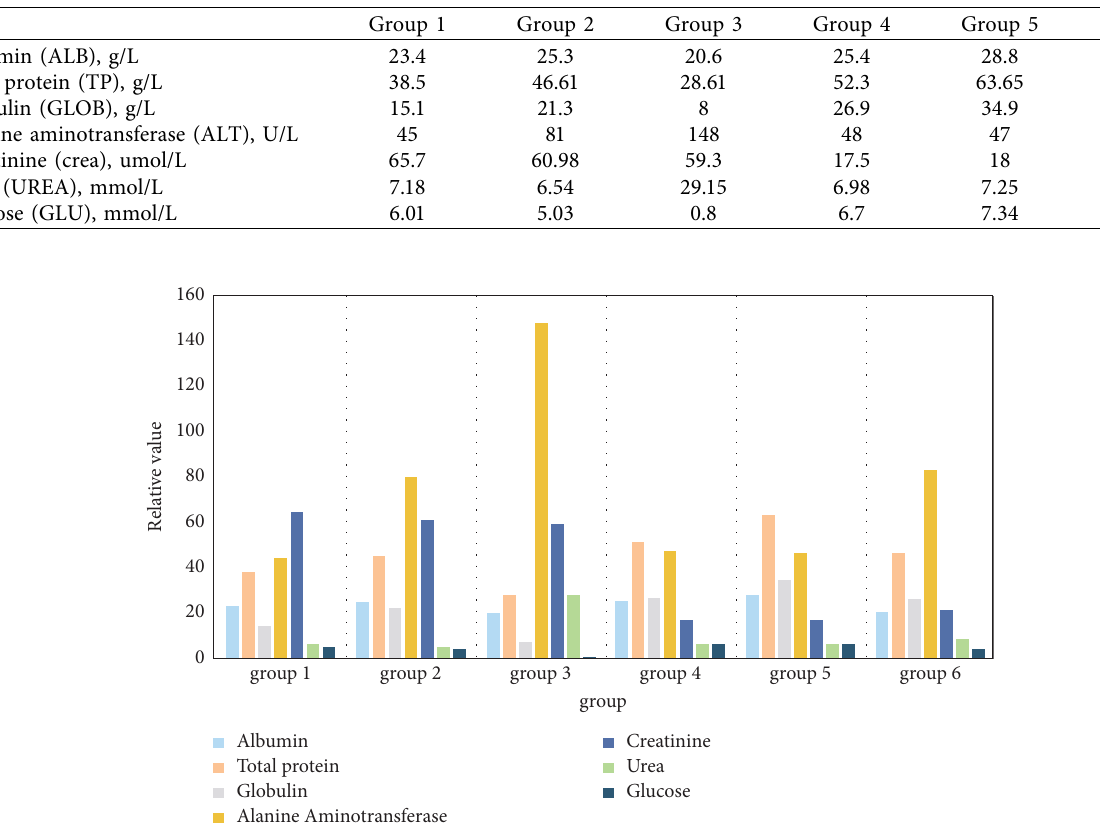
Figure 11: Analysis of biochemical test results in diferent groups of nude mice. ALB � albumin; TP � total protein; GLOB � globulin; ALT � alanine transaminase; Crea � creatinine; UREA � urea; GLU �